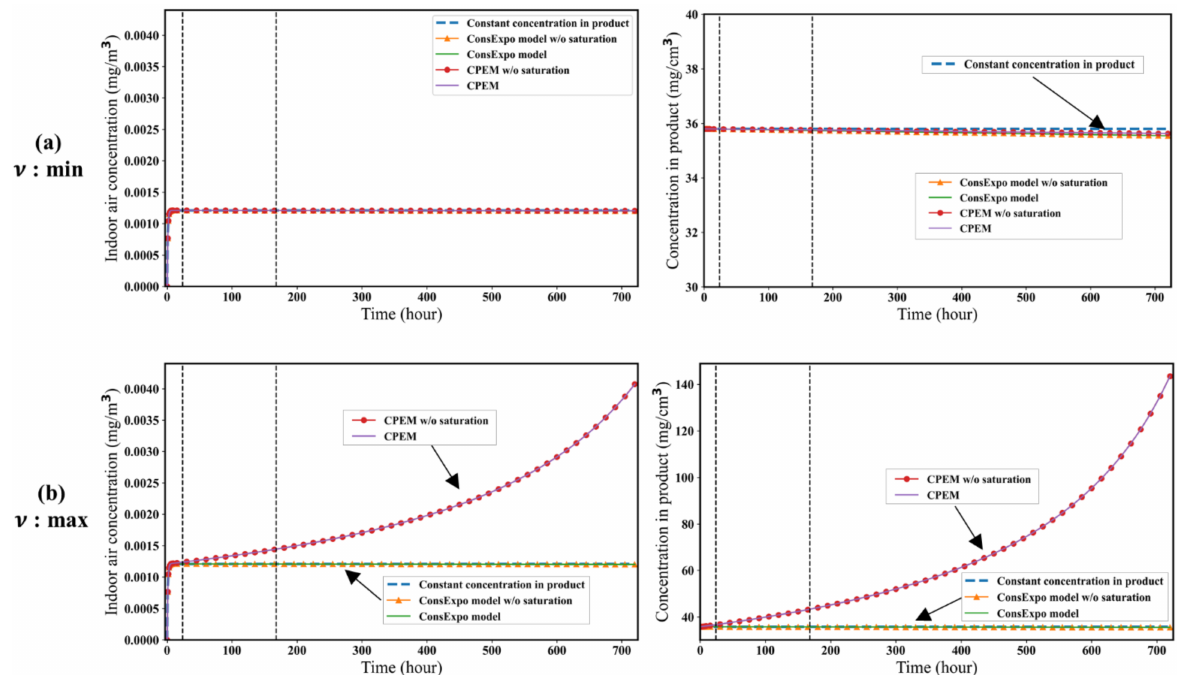
Figure 2. Comparison of the five models in the case where K and S are minimum. The figures on the left show the indoor air concentration of the substance, and the figures on the right show the substance concentration in the product. The dotted lines correspond to 1 day and 1 week, respectively.